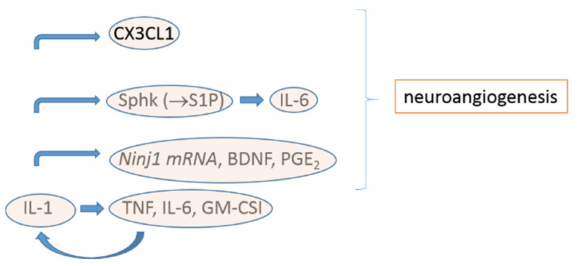
Figure 2. Proposed mechanism of stimulation of inflammatory mediators by IL-1 in endometriosis, as presented in this